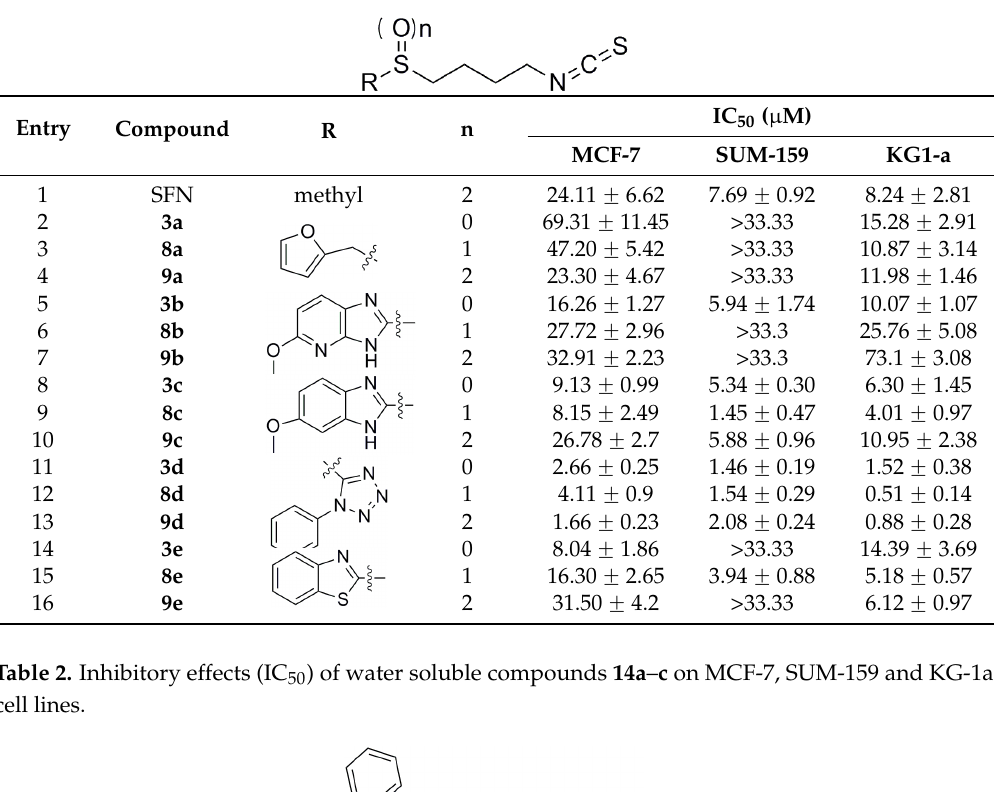
Table 1. Inhibitory effects of SFN analogues 3a – e , 8a – e , 9a – e on MCF-7, SUM-159 and KG-1a cell lines.